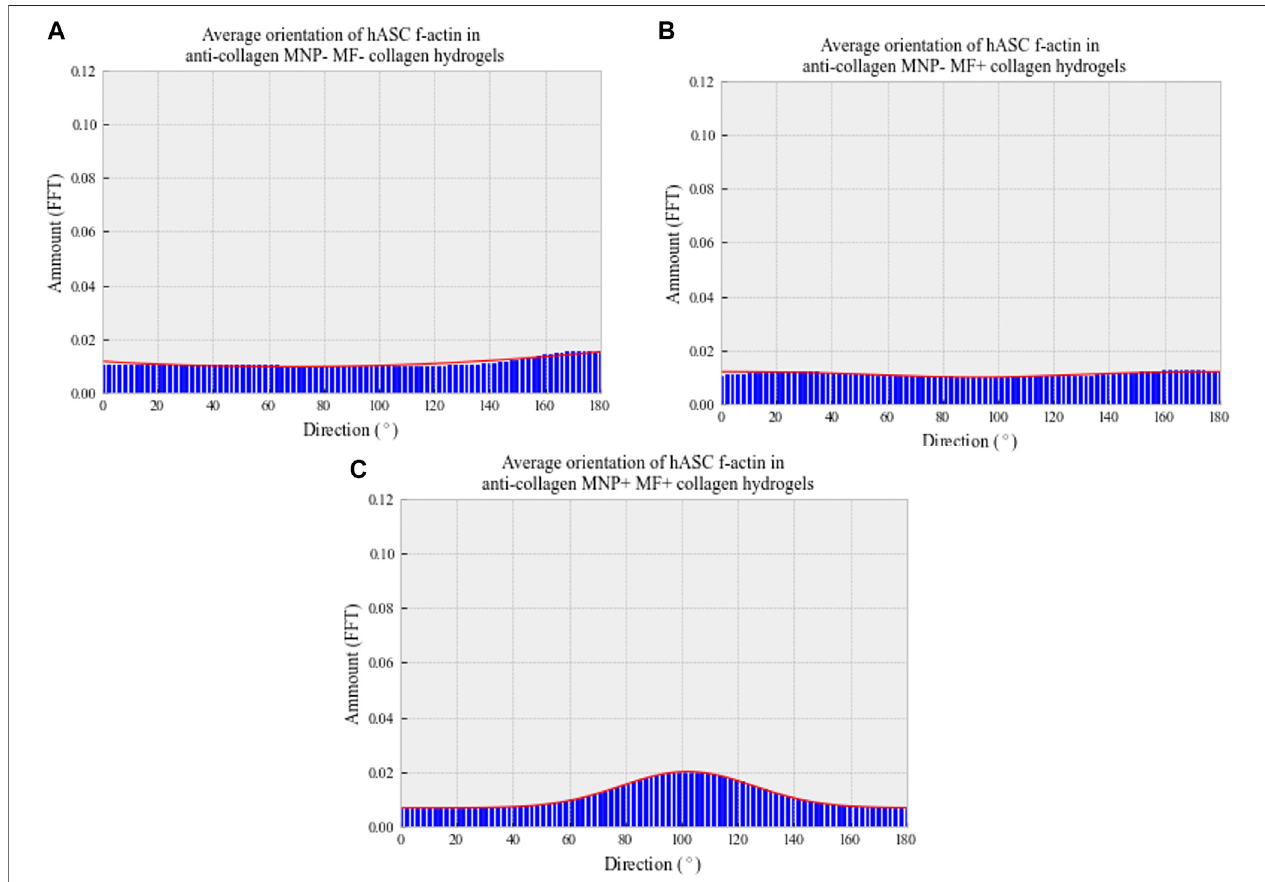
FIGURE 8 | Average directionality histograms of hASC f-actin 7 days post-gelation in collagen hydrogels. Patient-isolated hASCs (passage 4) were seeded (250 cells/ μ l) into depolymerized collagen suspensions, either with (C) or without (A,B) anti-collagen MNP dosing. Cell – collagen suspensions were then gelled and, if appropriate,amagnetic fi eldappliedfor30 minat37 ° C.Hydrogelswerethenimmersedinbasalmediaand fi xedfollowing7-dayincubation.F-actinwasvisualizedusing confocalmicroscopy,followingrhodaminestaining.OrientationdeterminedthroughImageJ ’ sDirectionalityplug-in,andaveragesplotted. n =3,trendline= fi ttothe Gaussian